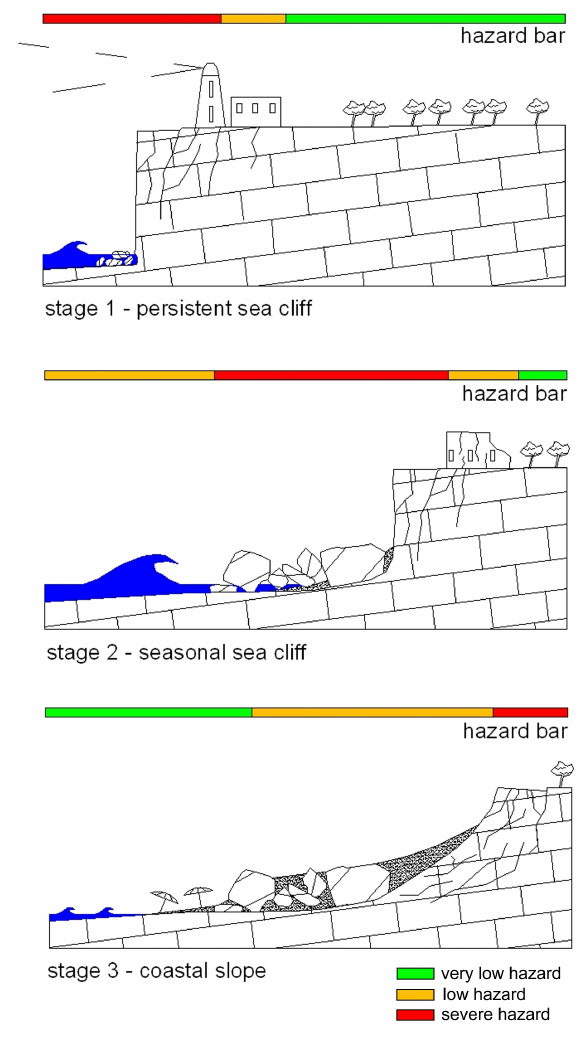
Fig. 1. Conceptual model showing the evolution from a sea cliff to a cliff slope and the related hazard